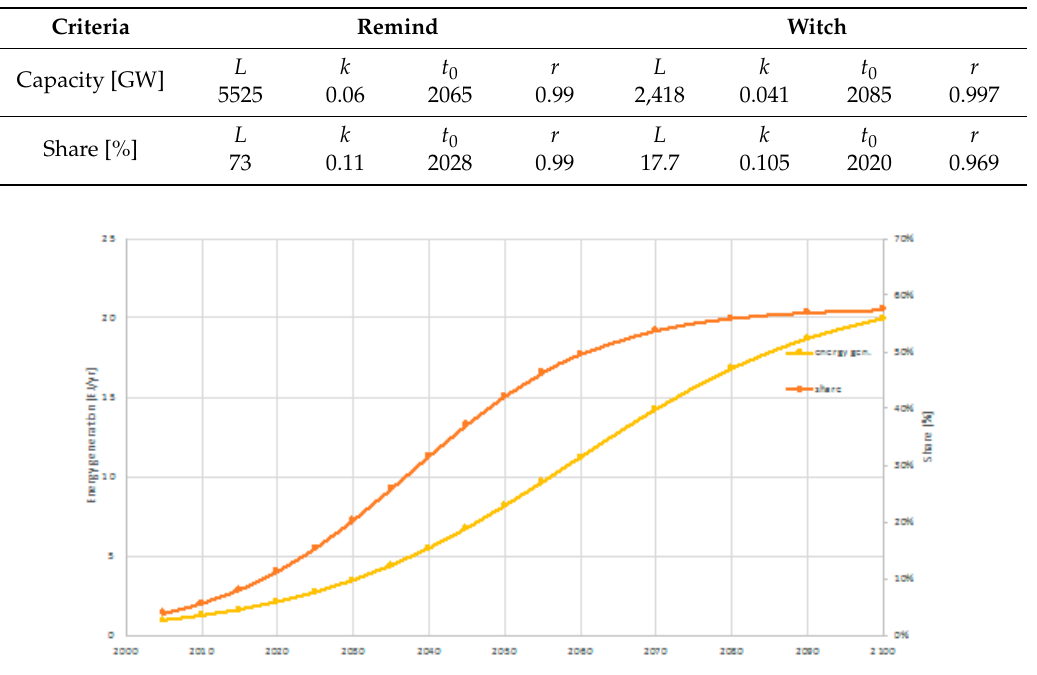
Table 7. Parameters calculated for the S-shaped curves (Figures 5 and 6).